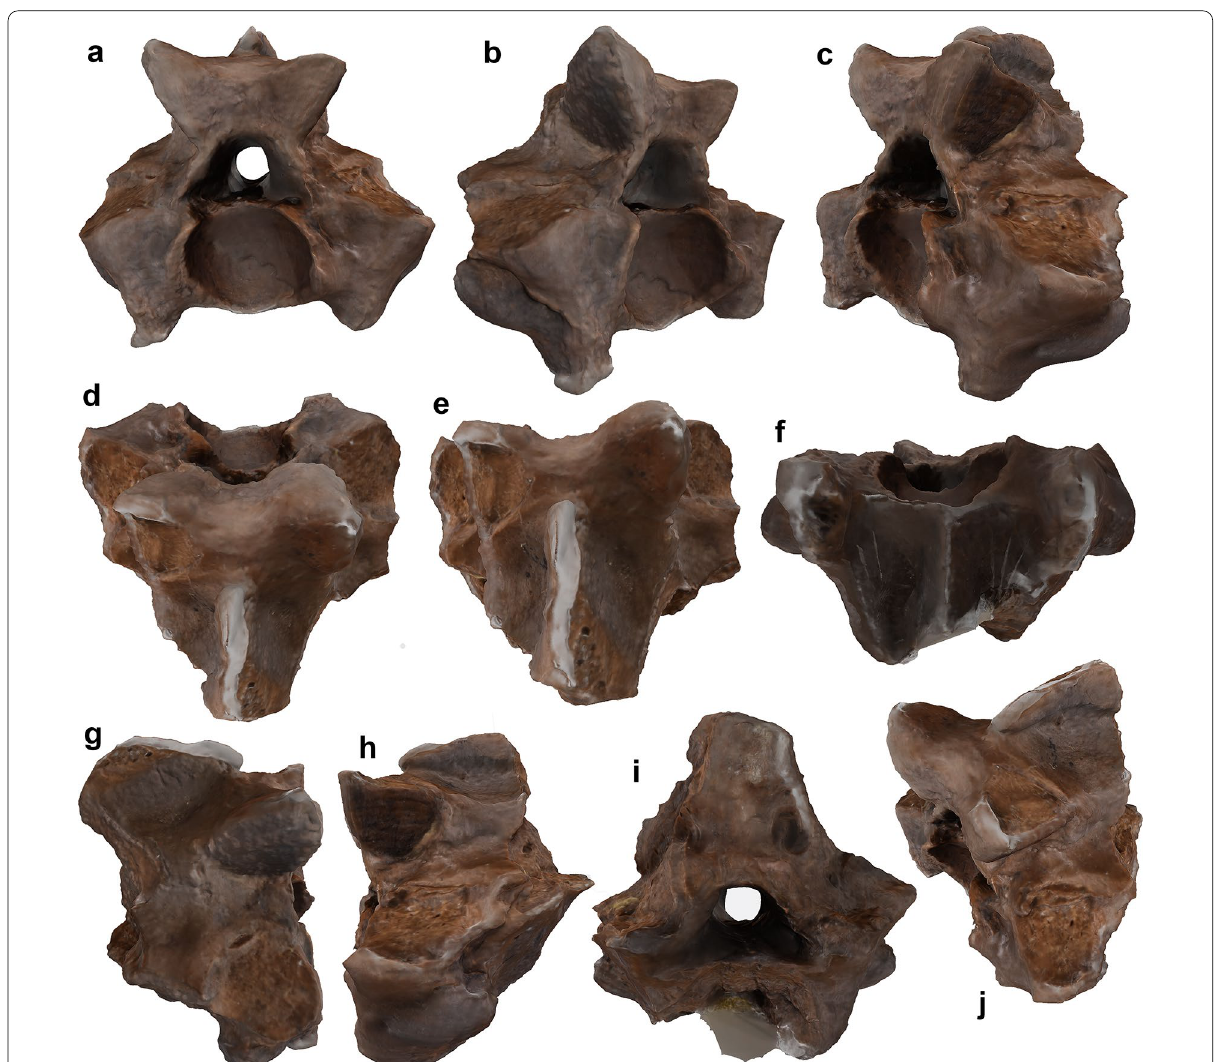
Fig. 19 Palaeopython ceciliensis from quarry Cecilie I, Geiseltal, holotype: 3D models of mid-trunk vertebra (GMH Ce I-2978-1926) in anterior ( a ), anterolateral ( b , c ), anterodorsal ( d ), dorsal ( e ), ventral ( f ), right lateral ( g ), left lateral ( h ), posterior ( i ), and dorsolateral ( j ) views. Images only at approximately the same